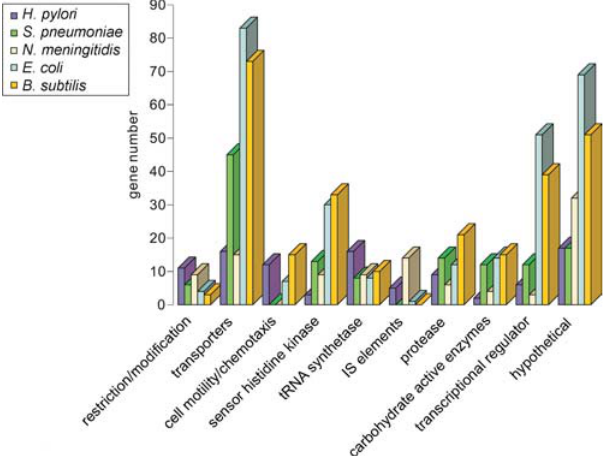
Figure 6. Abundance of SVGs in Different Functional Categories in Five Microorganisms The approximate total gene number for each organism is as follows: H. pylori , 1,566 genes; S. pneumoniae , 2,094 genes; N. meningitidis , 2,065 genes; E. coli , 4,289 genes; B. subtilis , 4,100 genes. DOI: